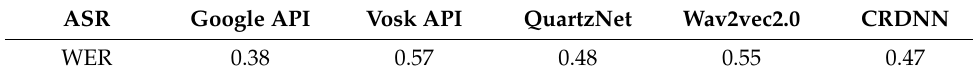
Table 2. WER results of ASR systems on the MoroccanFrench corpus.